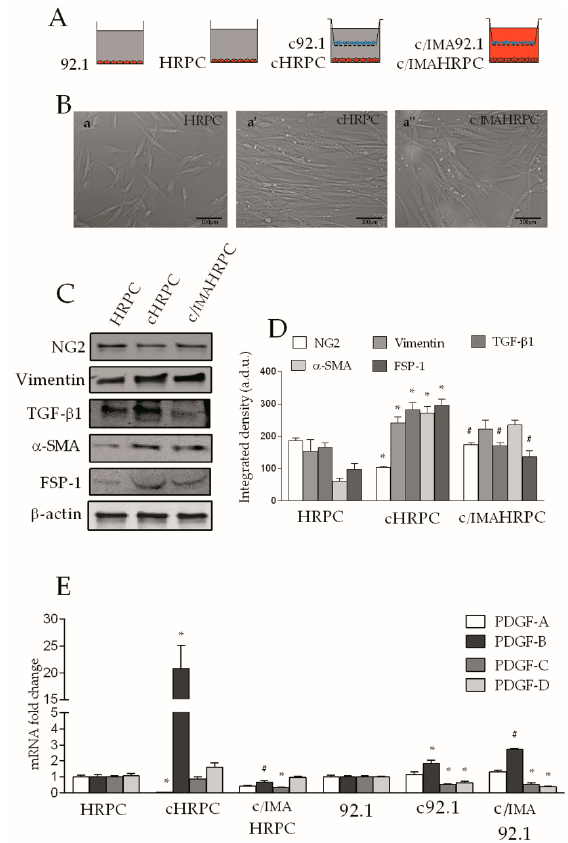
Figure 1. Imatinib prevents marker expression changes in human retinal pericytes (HRPC) induced by the interaction with 92.1 uveal melanoma (UM) cells. Human retinal pericytes were grown alone (control HRPC) or were conditioned in the presence of 92.1UM (cHRPC) with or without 5 μ M of imatinib (c/IMAHRPC) for 6 days ( A , B ): representative images of HRPC ( a ), cHRPC ( a’ ), and c/IMAHRPC ( a’’ ) after 6 days of conditioning. ( C ): Western blot analysis of NG2, vimentin, TGF- β 1, α -SMA, and FSP-1 proteins in control pericytes (HRPC), cHRPC, and c/IMAHRPC. β -actin detection indicates the same loading of 30 μ g of protein in each lane. ( D ): immunoblot quantification of through densitometric analysis of each band (in arbitrary densitometry units, a.d.u.), carried out with the Image J program. ( E ): quantification of PDGF-A, PDGF-B, PDGF-C, and PDGF-D mRNA expression levels by qRT-PCR in both HRPC and 92.1UM grown alone and in coculture with or without 5 μ M of imatinib. Bars represents the means ± SEM from three independent experiments. * p < 0.05 vs. control (HRPC or 92.1UM); # p <0.05 vs. coculture without imatinib. One-way ANOVA, followed by Tukey’s test.